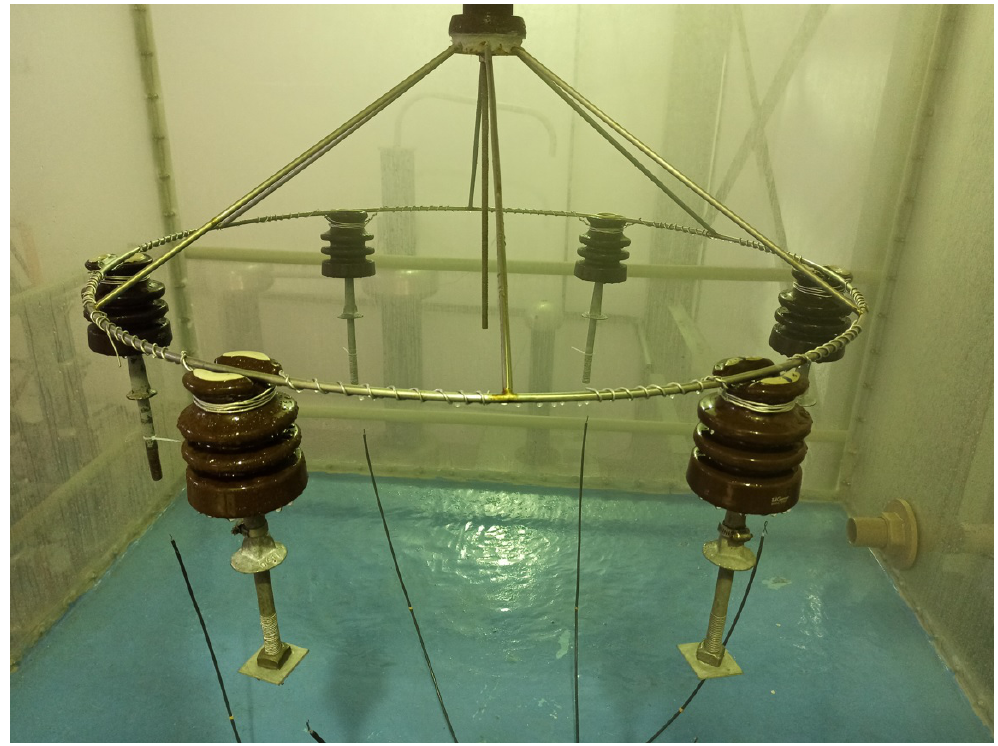
Figure 1. Insulators in a saline chamber